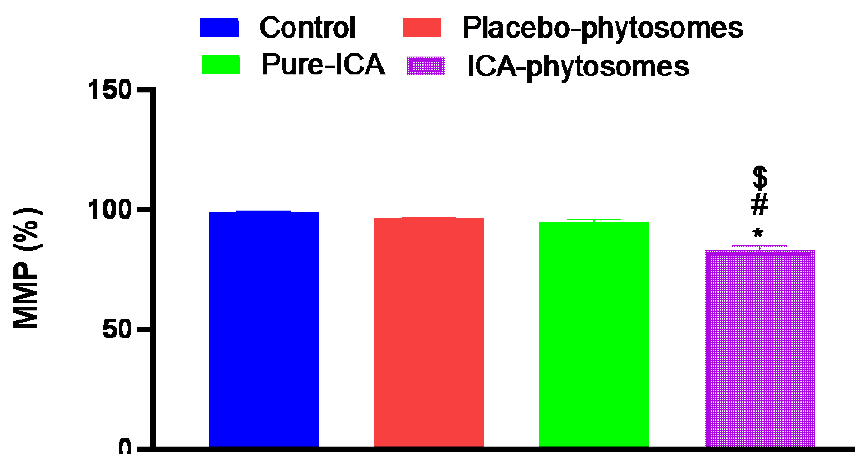
Figure 9. Effect of ICA-phytosomes on mitochondrial membrane potential (MMP) in OVCAR-3 cells. * Significantly different from control at p < 0.05, # significantly different from placebo-phytosomes at p < 0.05, $ significantly different from pure-ICA at p < 0.05.